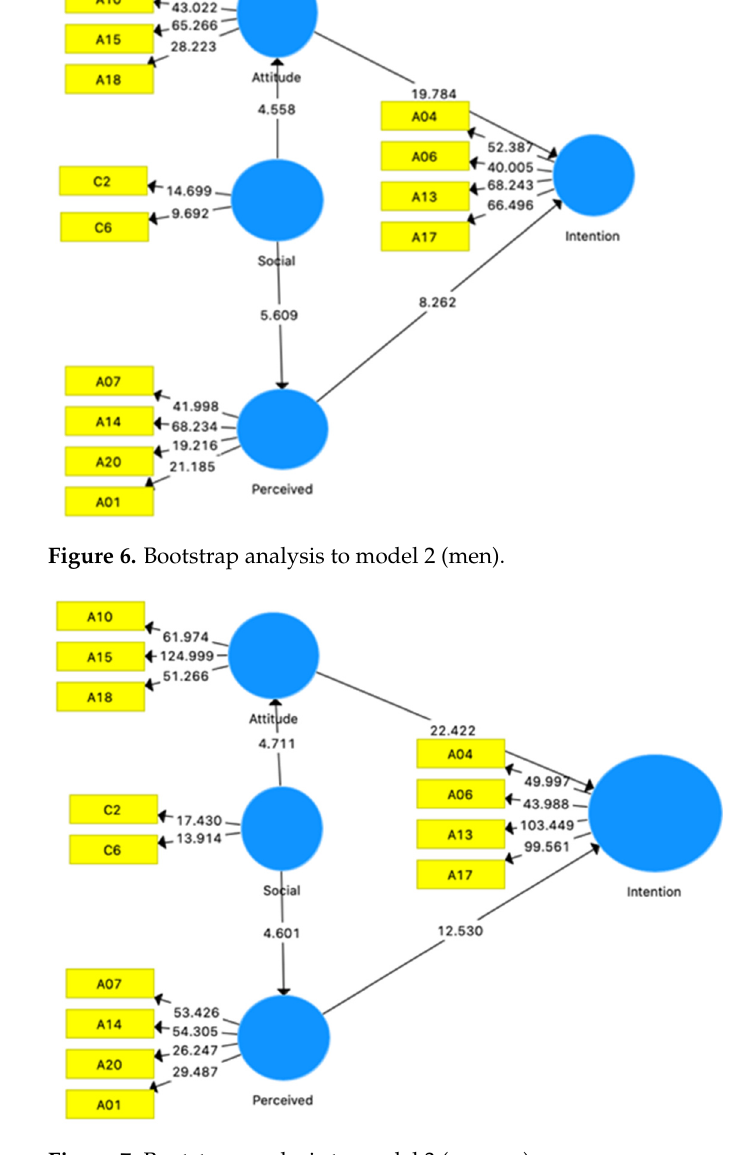
Figure 7. Bootstrap analysis to model 3 (women). All latent variables are significant ( ρ = 0.000) for a statistical significance of 95%, and the results are show in Table 6. Table 6. Multigroup analysis.